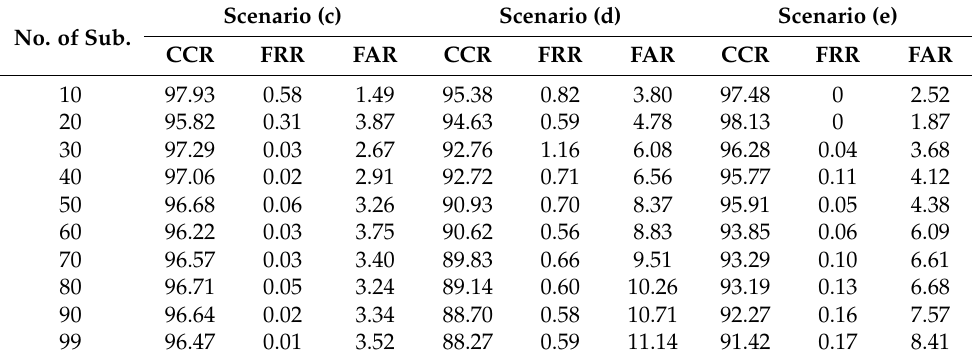
Table 4. Correct Classification Rate, False Rejected Rate and False Accepted Rate for scenarios: (c), (d) and (e). Scenario No. of Sub.